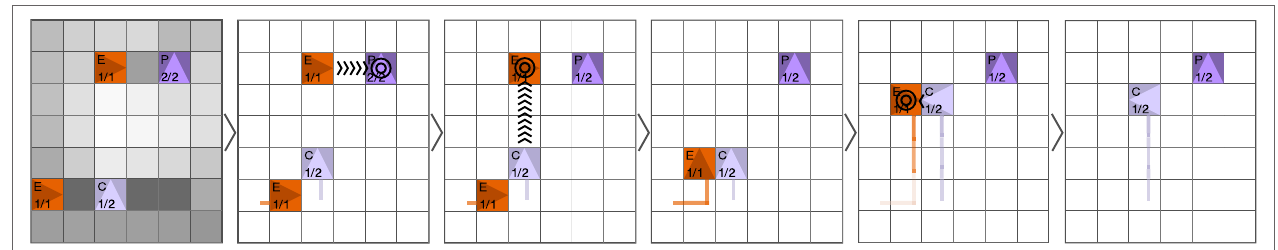
FiGUre 6 | Companion (C) and player (P), both purple, are threatened simultaneously by two enemies (E), both red. The images represent the successive moves: the companion escapes its own death, rescues the player, and finally defends itself. Left: combined heuristics for 2-step empowerment (see text), lighter colors indicating higher empowerment. Arrows indicate shooting. Figure taken from Guckelsberger and Salge (2016), reproduced with permission.